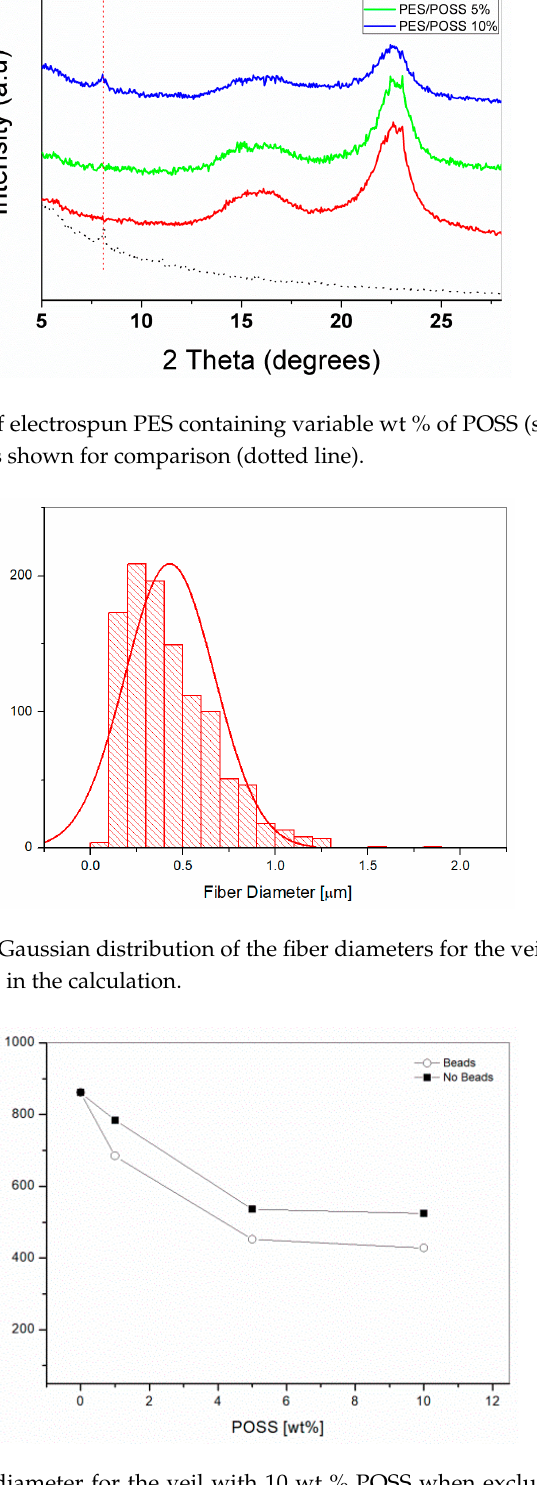
calculation. calculation. the